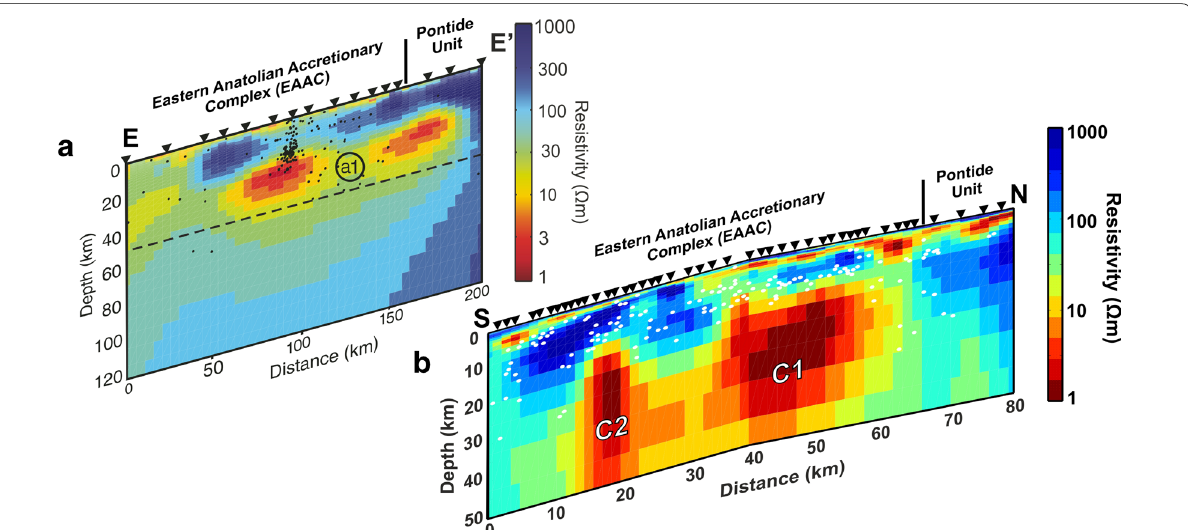
Fig. 9 Comparison of the geo-electric resistivity sections between profile E ′ -E from the previous 2D MT study (Türko ğ lu et al. 2008; Türko ğ lu 2009) ( a ) and the corresponding cross section from 3D MT interpretation ( b